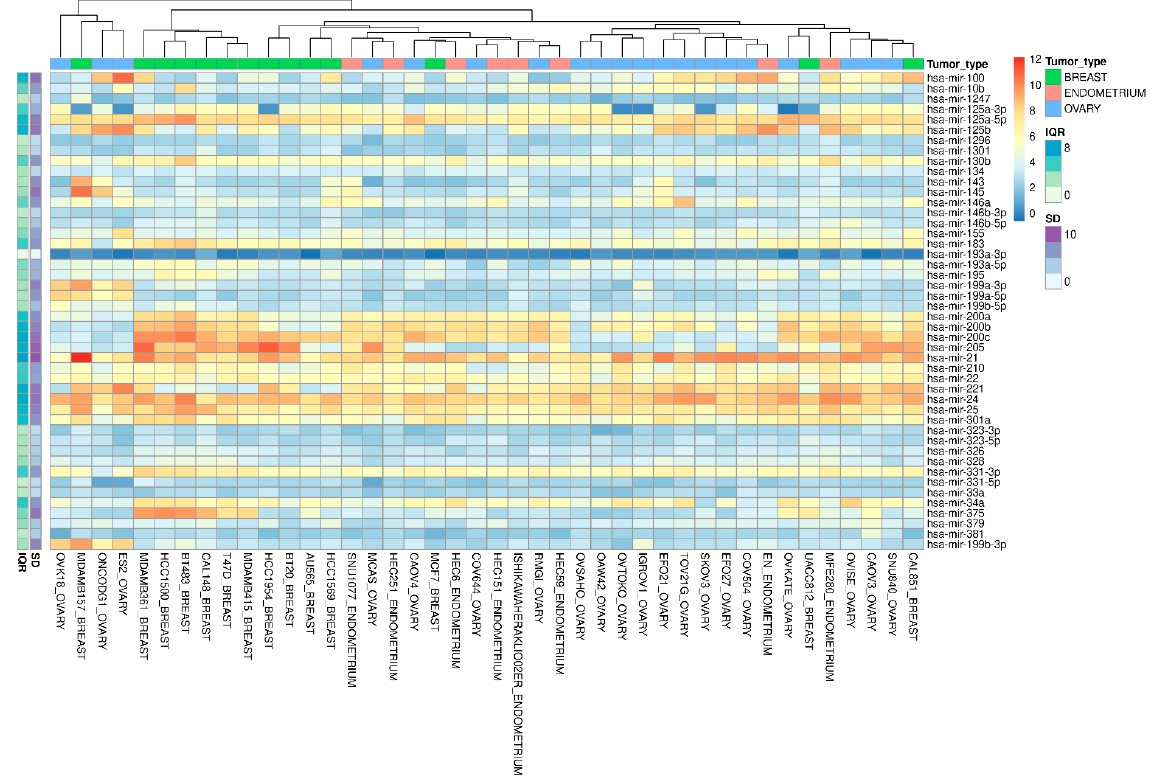
Figure 2. Heatmap with hierarchical clustering of the 39 out of 42 miRNA features within the Cancer Cell Line Encyclopedia (CCLE) across female primary “breast”, “ovary”, and “endometrium” carcinoma. Left columns show standard deviation (SD) and interquartile range (IQR) for each miRNA along all cell lines. In the columns, cell line clusters for miRNA expression signature similarity are reported.